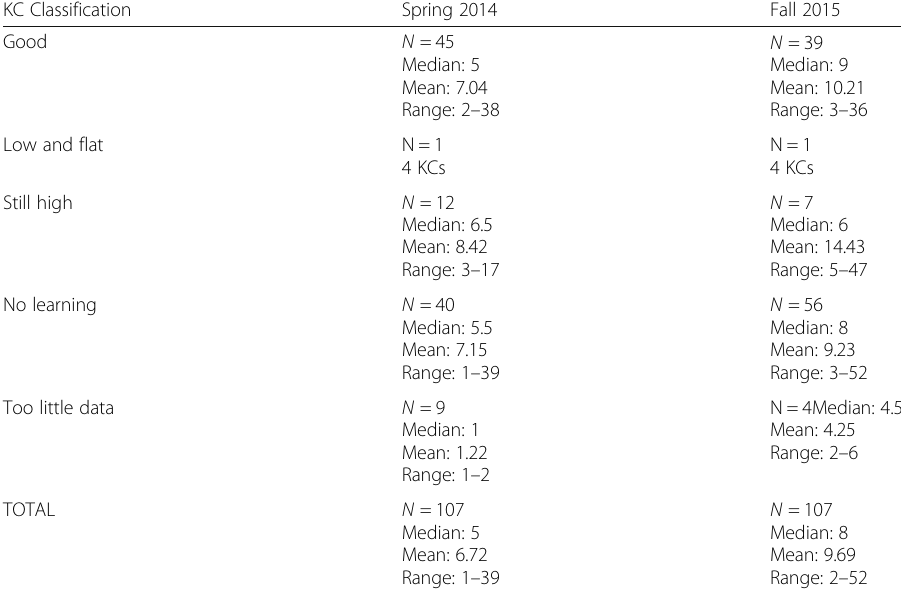
Table 7 Problems per KC for the 2014 and 2015 Statistics courses KC Classification